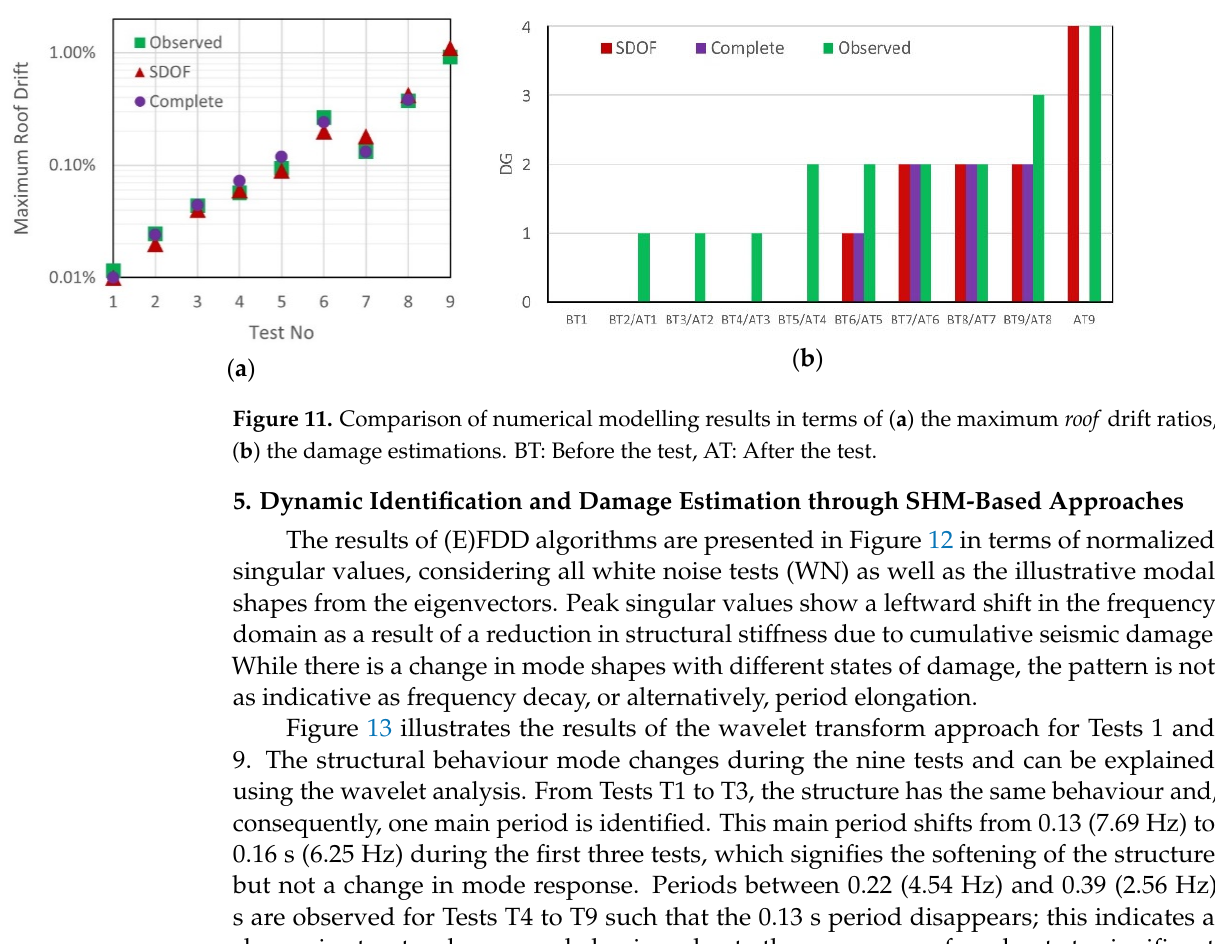
Figure 12. Dynamic identification results using noise − based evaluations from (E)FDD.